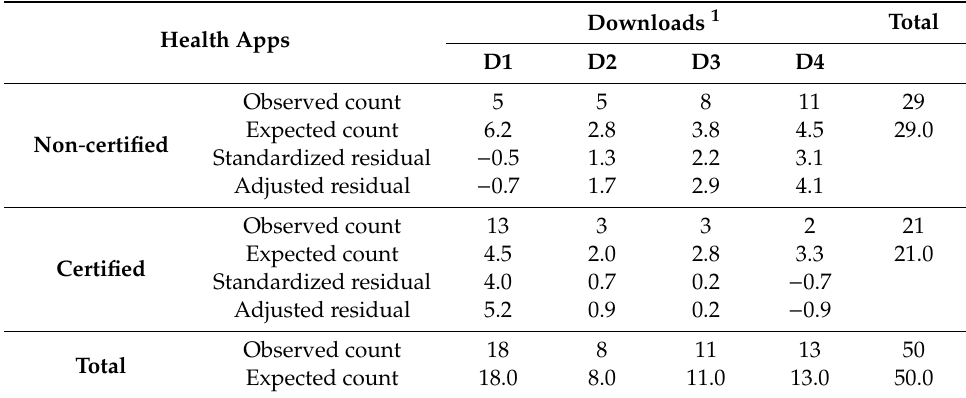
Table 5. Contingency table downloads and quality